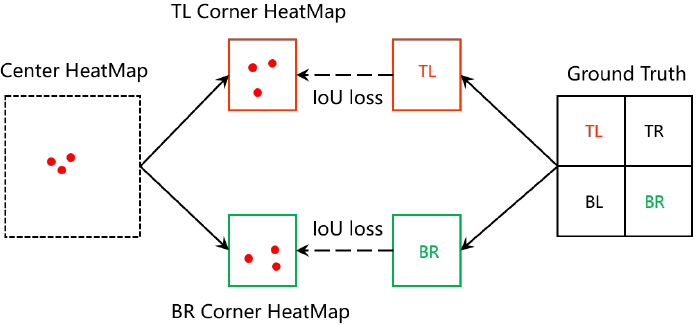
Figure 3. The architecture of key prediction network (KPN). TL is top-left corner, TR is top-right corner, BL is bottom-left corner, BR is bottom-right corner, and IoU is intersection over